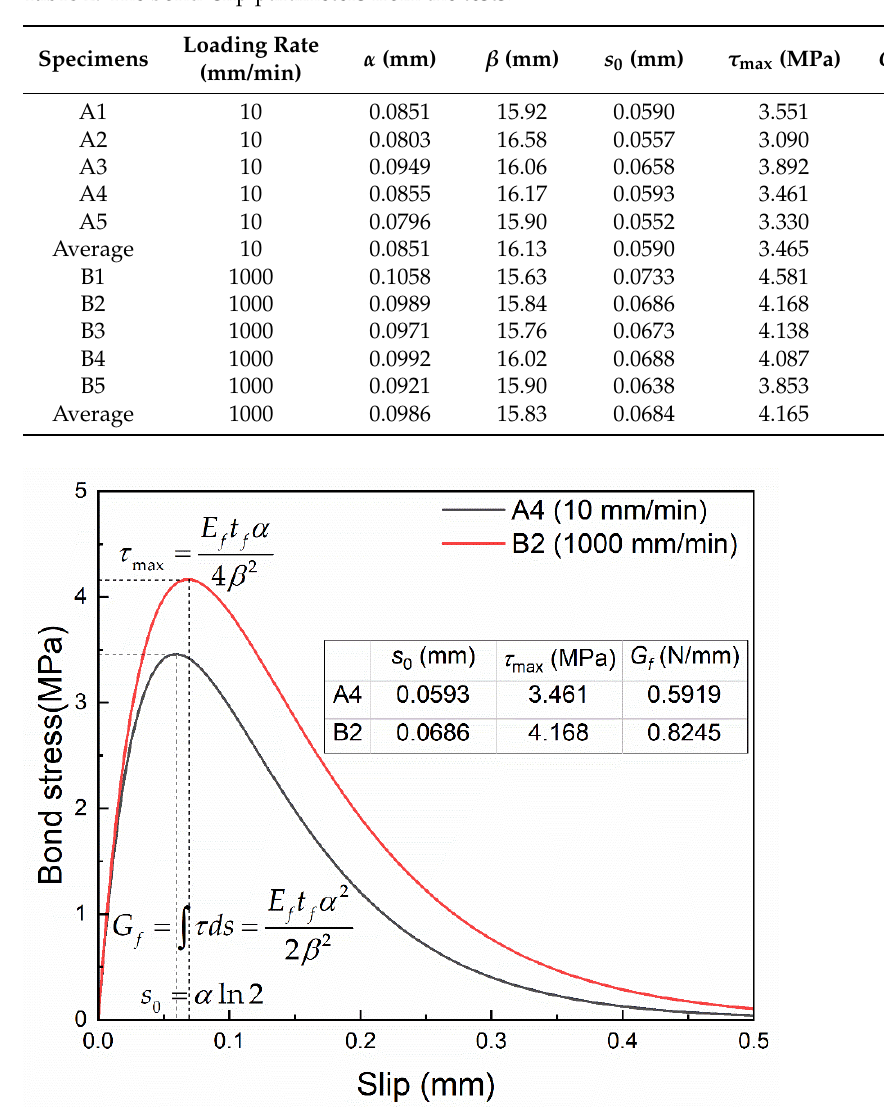
Figure 9. Bond–slip curves for Specimens A4 and B2.